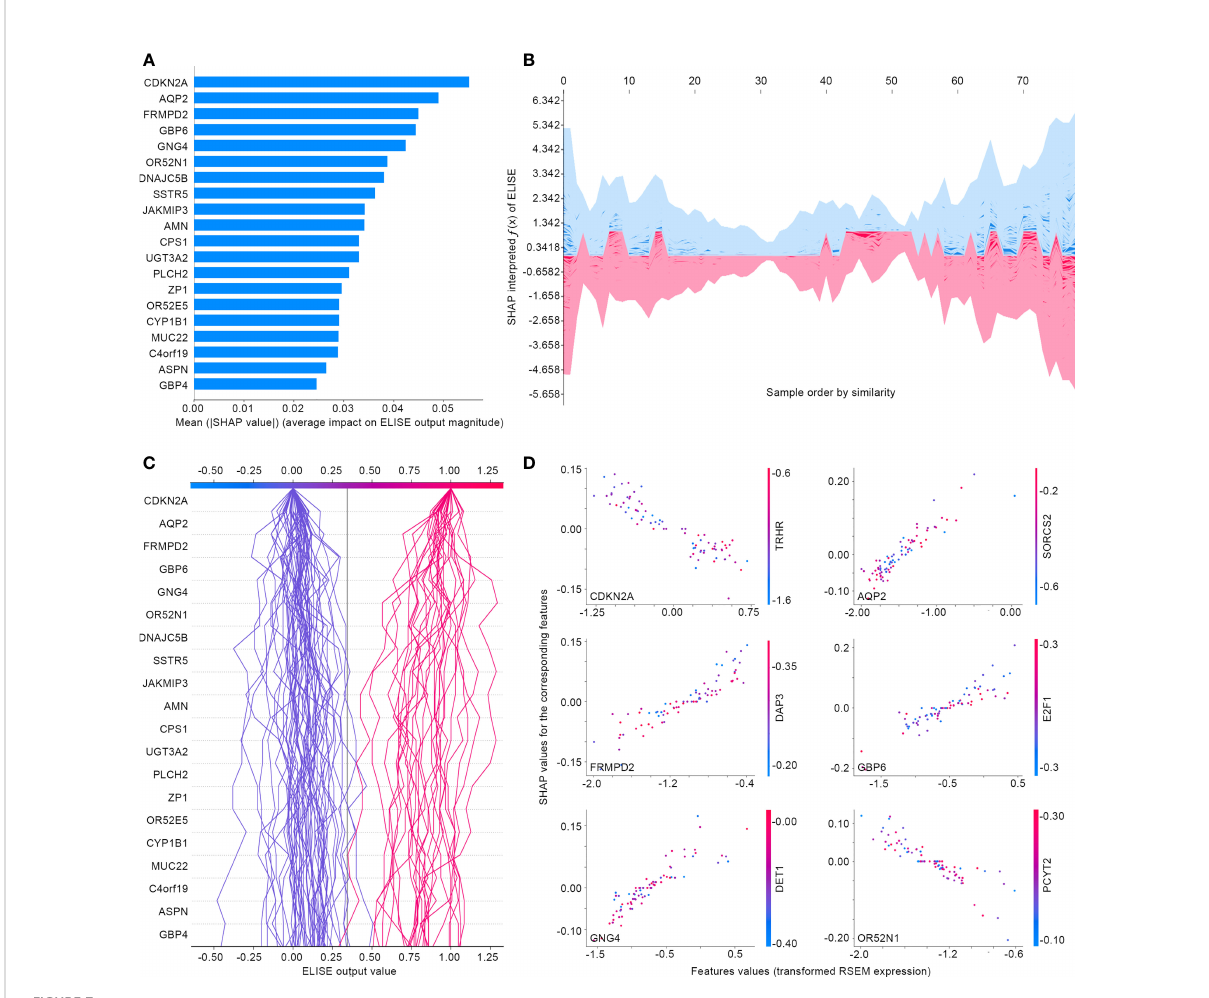
algorithm ranked all inputted features according to their mean